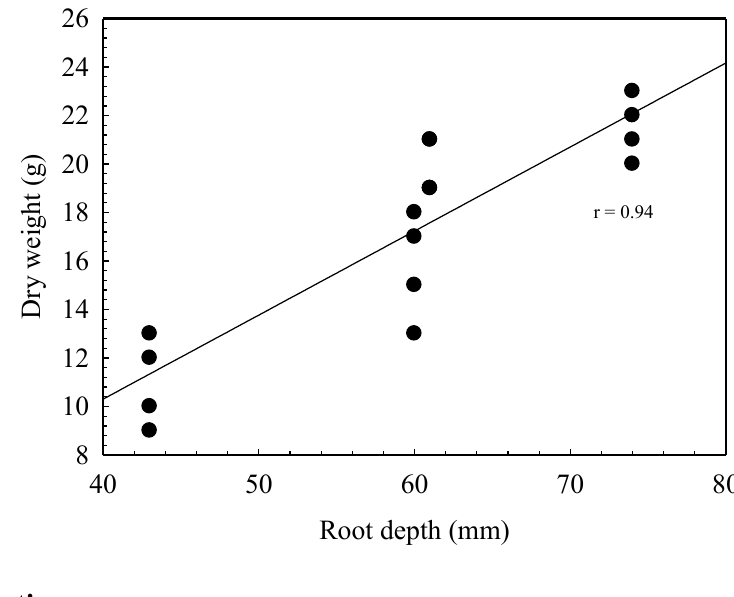
Figure 6. Correlation analysis between turfgrass root depth and turf yield (expressed as dry